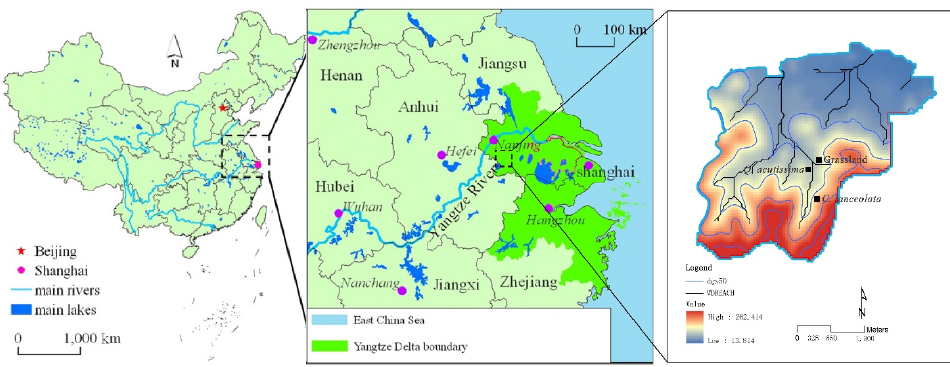
Figure 1. Study regional location and elevation map. The soil type was yellow brown and the slope direction was northeast (NE). The soil thickness was ~60 cm, beyond which was weathered parent sandstone. The terrain comprised the southern Jiangsu hills at an altitude of from between 38–388 m, and